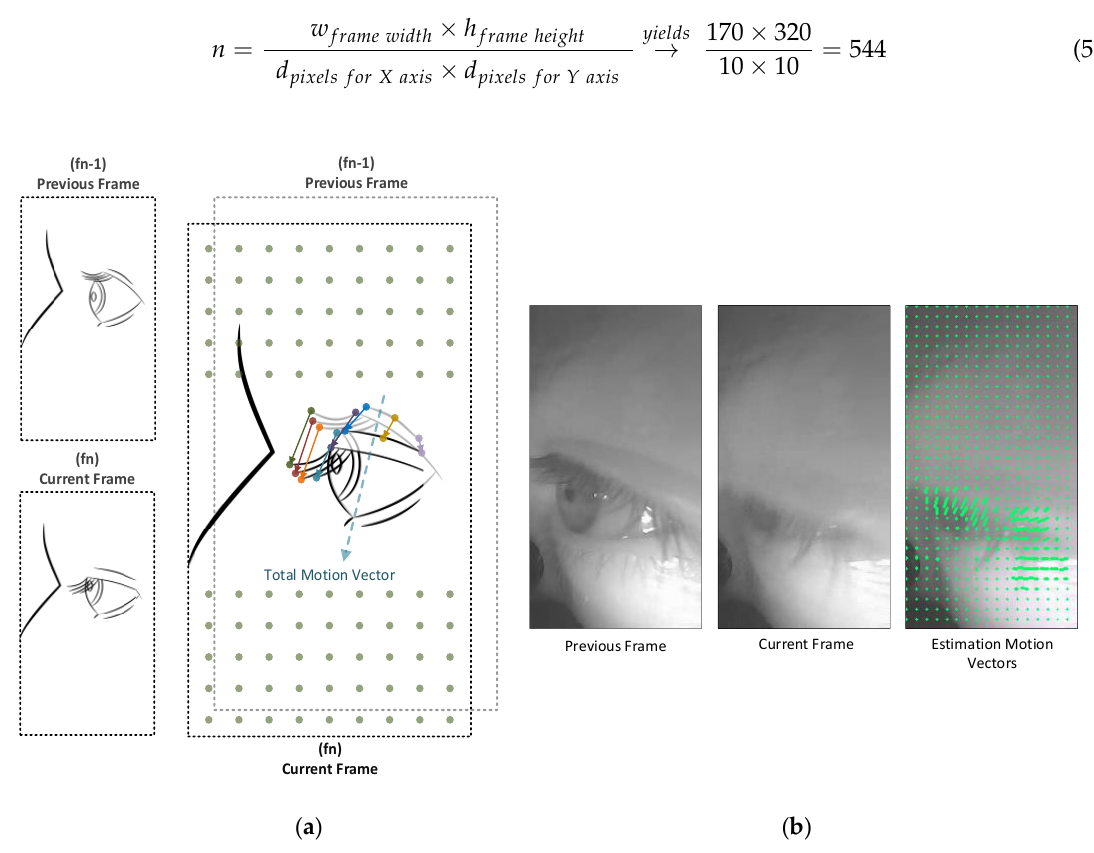
Figure 7. Illustration of an approximate estimation of a motion vector between two successive frames: ( a ) Two successively captured frames and how the motion vectors are estimated based on using the previous and current captured frames ( f n − 1 , f n , respectively), and how the sum of vectors represents the motion vector; ( b ) Real-case scenario, two captured frames and visualisation of the estimation motion vectors by the proposed algorithm.